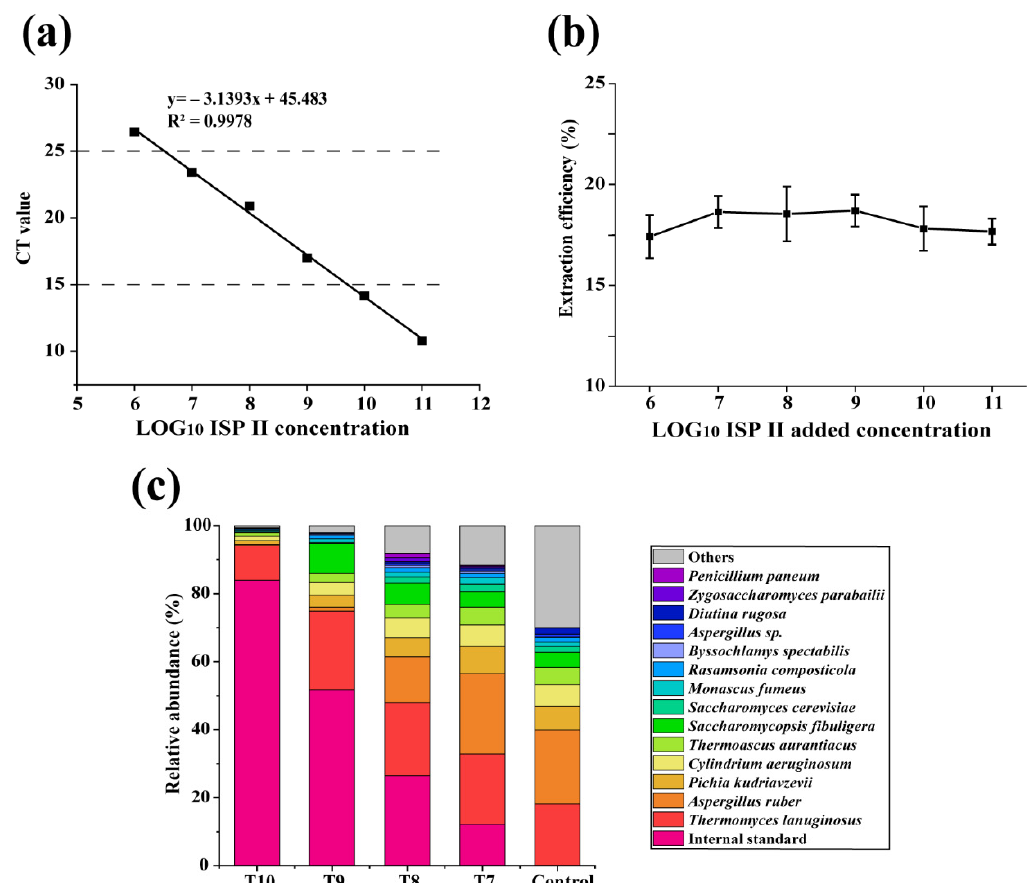
Figure 2. Selection of mixed ISP-added concentrations. ( a ) Standard curves of ISP II. ( b ) The extraction efficiency of ISP II in high-temperature mature Daqu. ( c ) Relative abundance of the high-temperature mature Daqu with different concentrations of ISP II added at the species level.